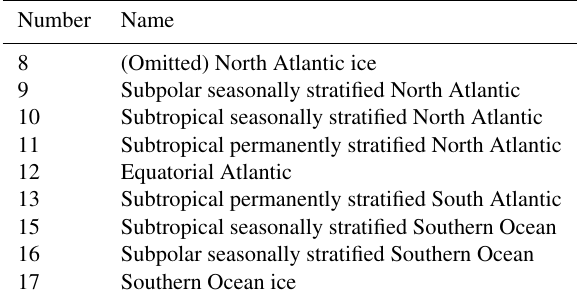
Table 2. Biomes from Fay and McKinley (2014) used for time se- ries comparison (Fig.